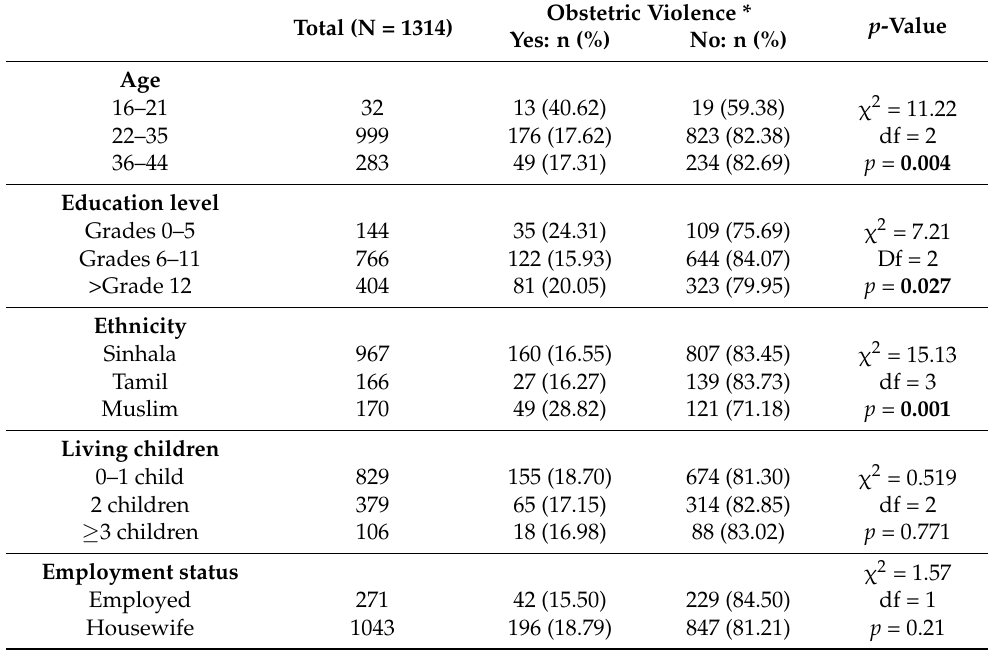
Table 2. Background characteristics of pregnant women reporting obstetric